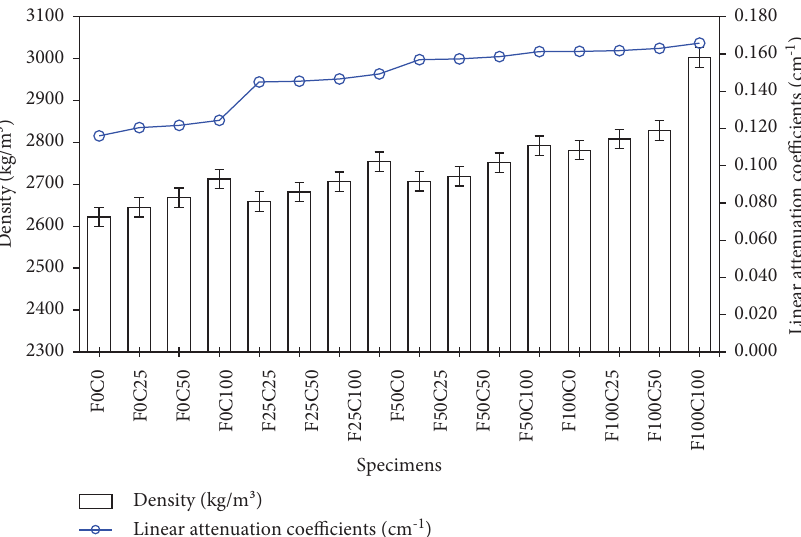
Figure 11: LAC and density of the specimens.